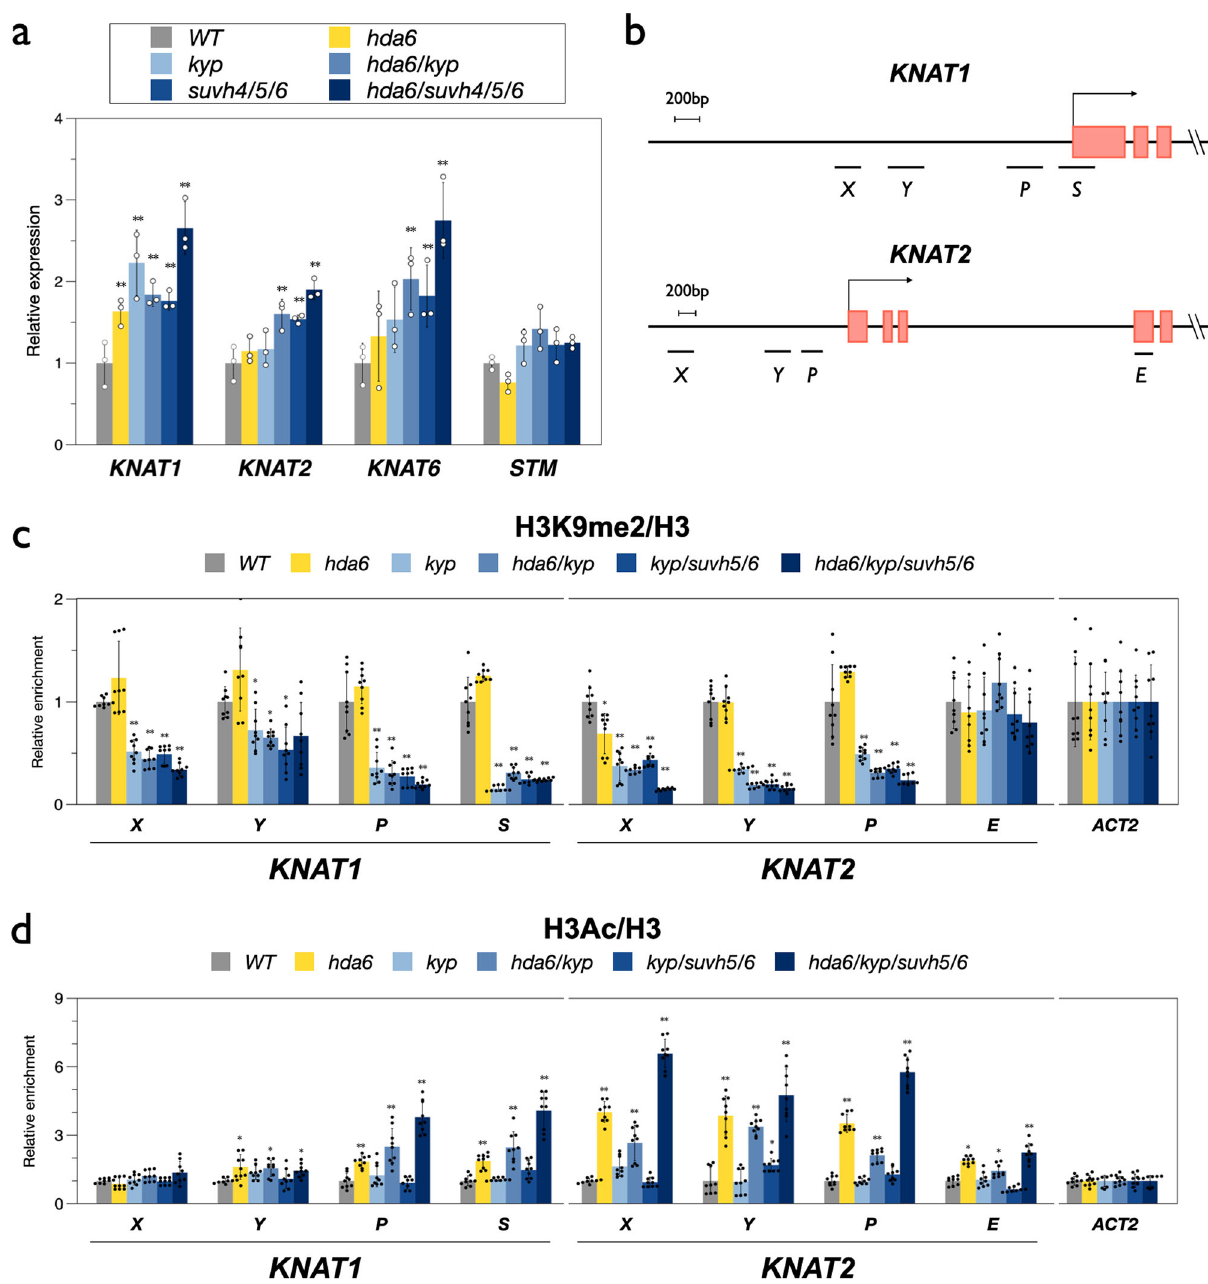
Fig. 3 KYP, SUVH5, SUVH6 and HDA6 synergistically regulate KNAT1 and KNAT2 by H3K9me2 and H3 deacetylation. a Expression of KNOX genes in hda6, kyp, had6/kyp, kyp/suvh5/6 , and hda6/suvh4/5/6 mutants. Gene expression was analyzed by RT-qPCR. RNA was extracted from 10-day-old plants grown under LD conditions. UBQ10 was used as an internal control. Error bars indicate SD. ** p < 0.01 by t test. At least three independent biological replicates were performed with similar results. b Schematic diagrams of KNAT1 and KNAT2 genomic sections. The promoter regions (X, Y, and P), fi rst exon (S), and coding region (E) analyzed in ChIP-qPCR are indicated. c , d ChIP-qPCR analysis of H3K9me2( c ) and H3Ac( d ) levels on KNAT1 and KNAT2 in 10- day-old plants. The amounts of DNA after ChIP were quanti fi ed by qPCR. The values of relative enrichment were normalized by the value of total H3, and ACT2 was used as internal control. Data points represent average of three technical replicates. Error bars correspond to standard deviations from three biological replicates. * p < 0.05, ** p < 0.005 (Student ’ s t